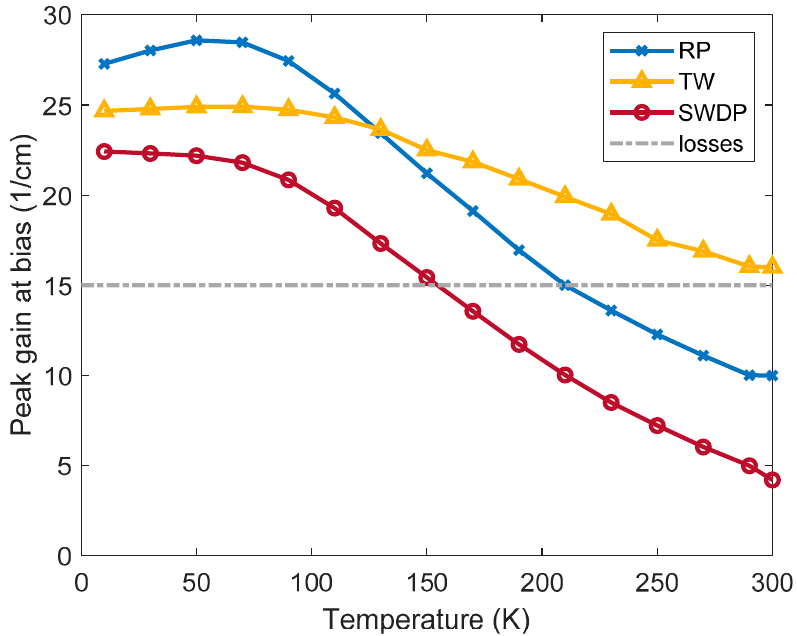
Figure 3. Peak gain as a function of temperature for a bias voltage of 86 mV/module, 70 mV/module, and 46 mV/module for the RP, TW, and SWDP designs, respectively.